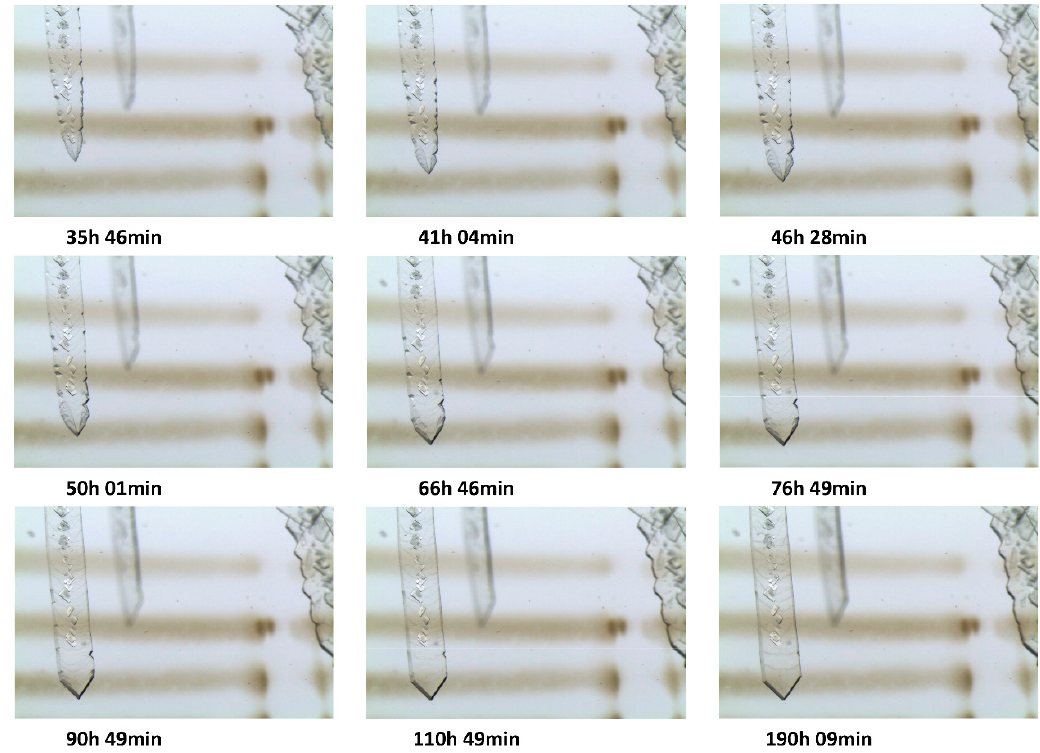
Figure 10. Optical microscopy images of the morphology evolution in the time-dependent crystal growth experiment of 1D- cha polymer (agarose concentration 0.1 w / v % ). The images show the morphological evolution of the crystal from an irregular morphology to a well-defined sword